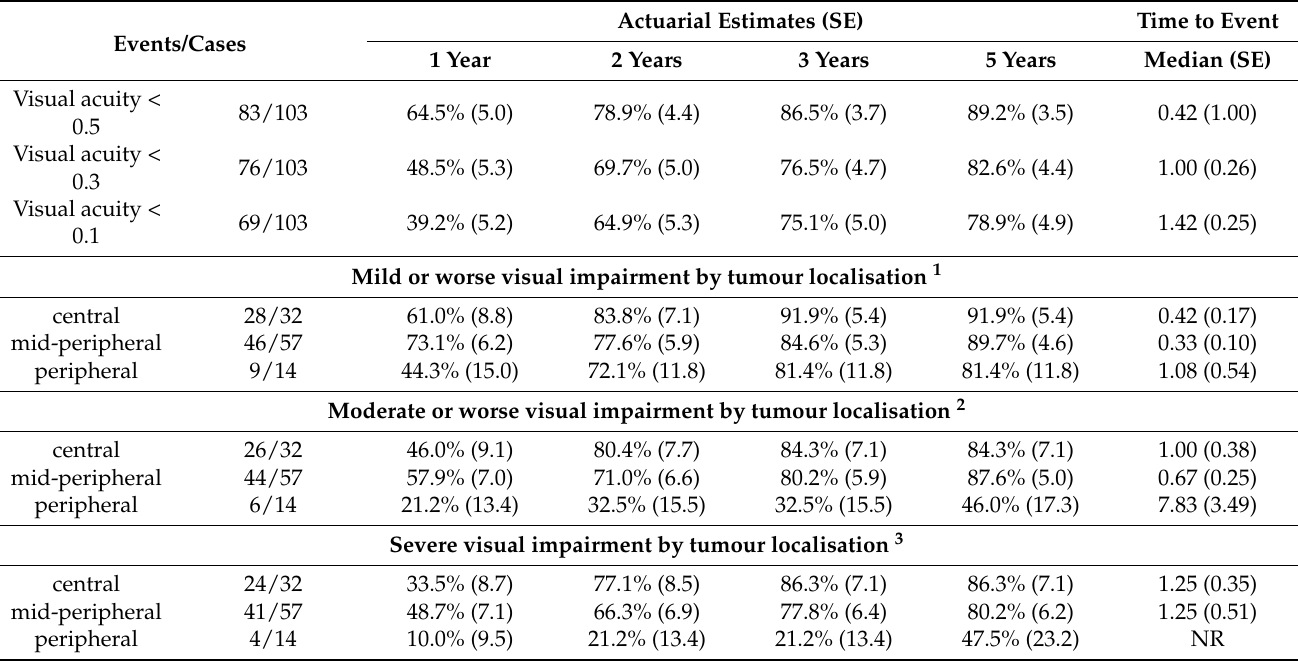
Table 3. Visual acuity following proton therapy for uveal